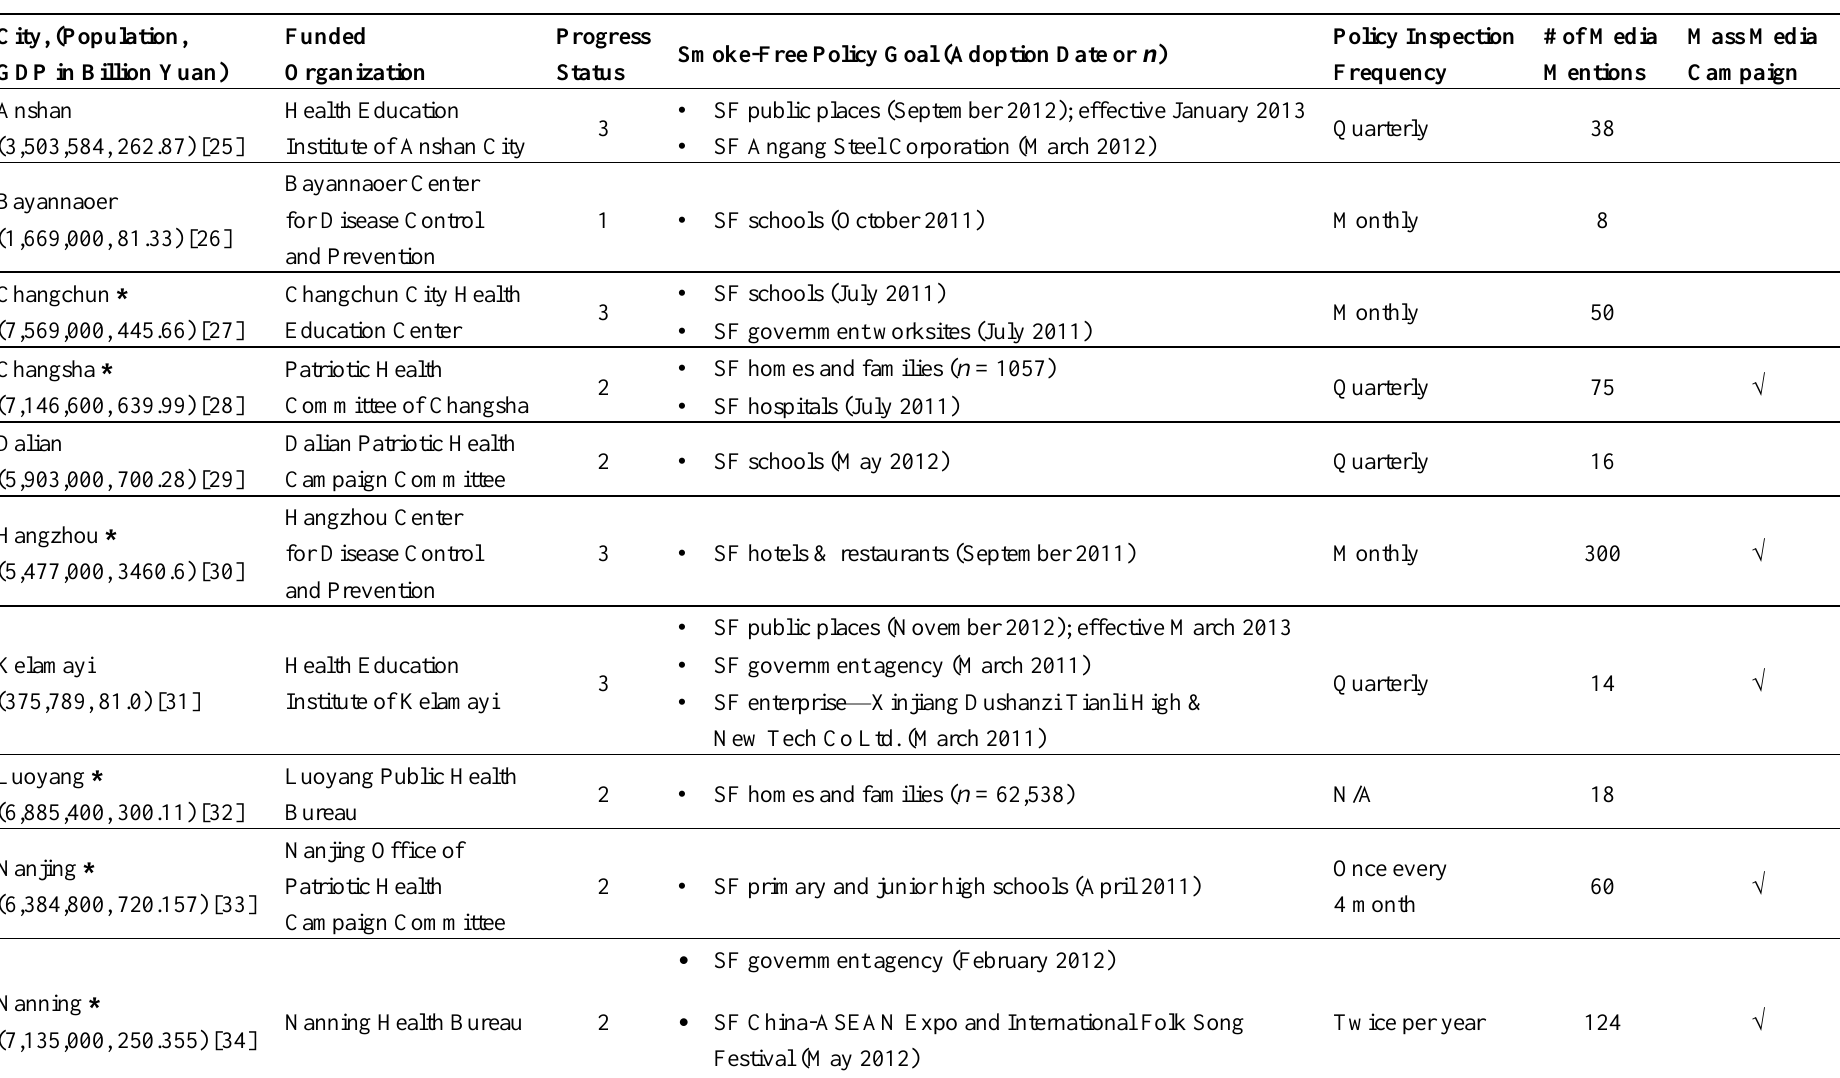
Table 1. Emory GHI—Tobacco Free Cities